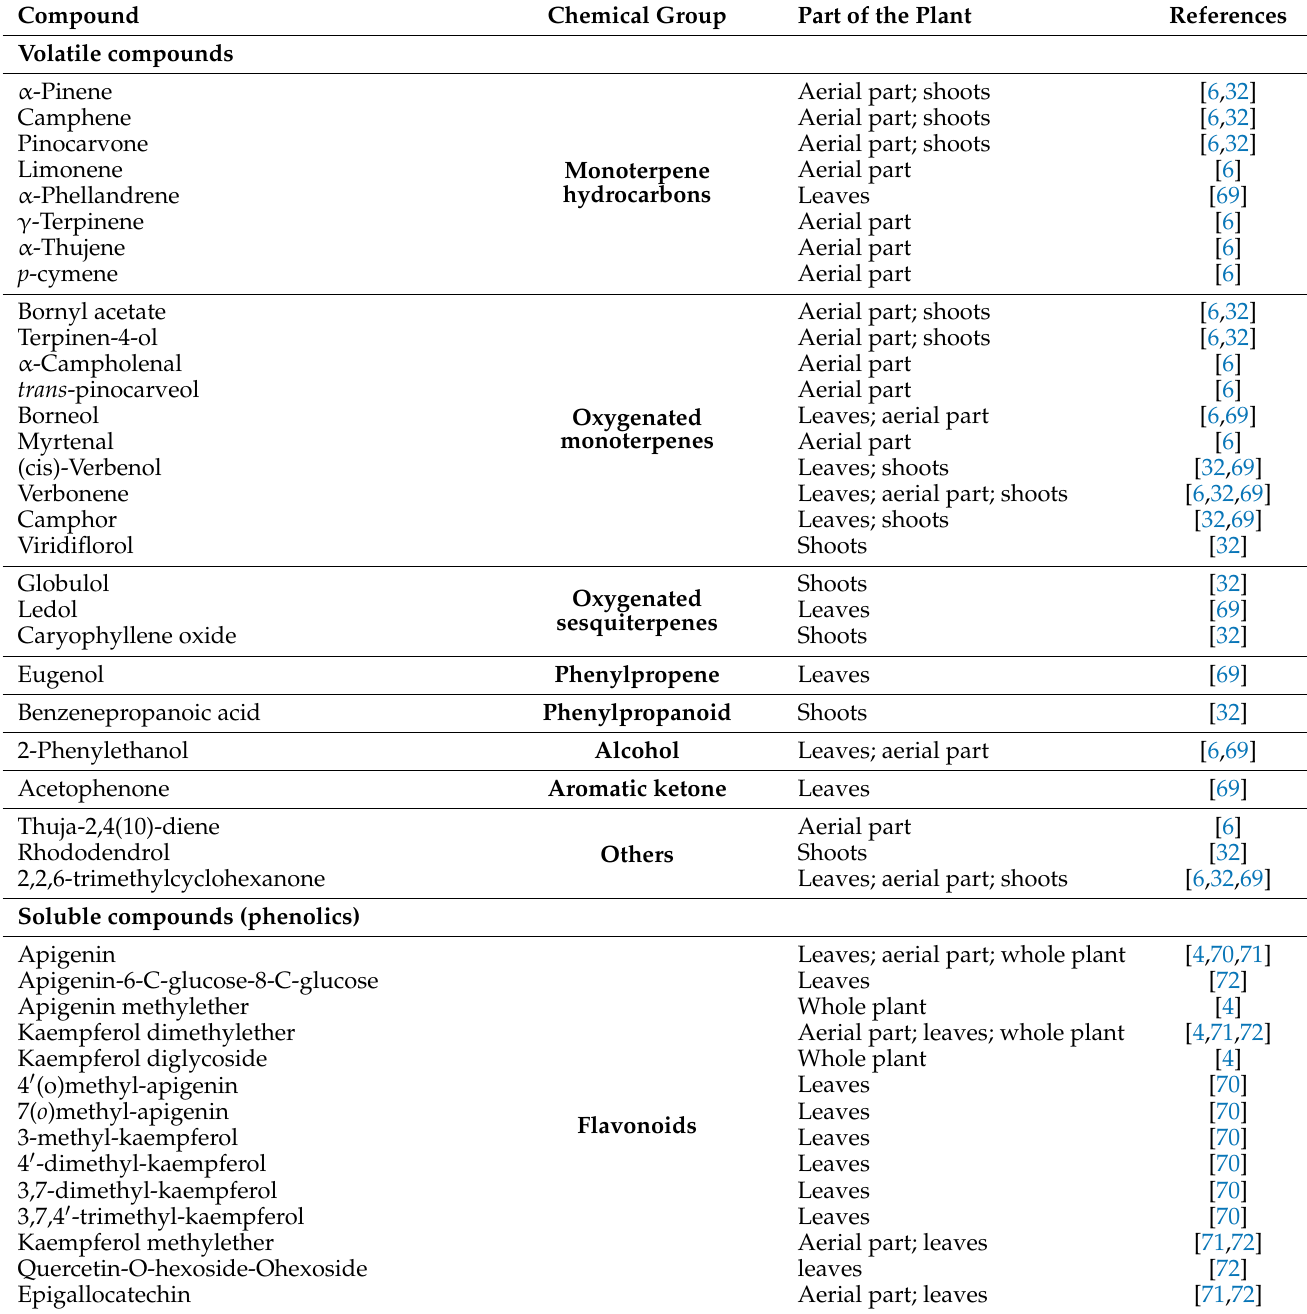
Table 2. Major phytochemical constituents of C. ladanifer extracts obtained from various parts of the